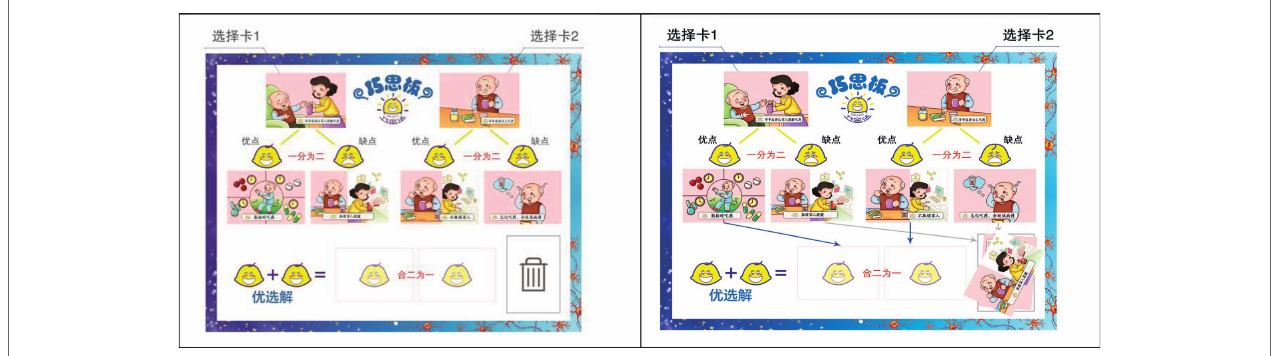
FIGURE 2 | Q-Pad for the case of “Grandpa’s Misgivings”: The first figure shows constraints for optimal solutions, and the second figure shows an achieved optimal solution.